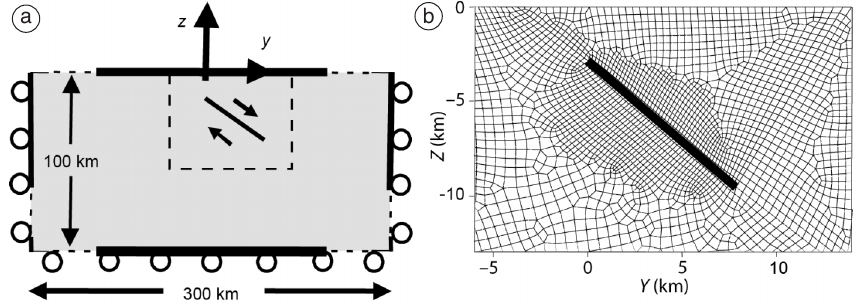
Fig. 1a,b. Two-dimensional finite element model: a) geometry (not on scale) and boundary conditions (circles represent no movement across the edge); b) enlargement of the quadrilateral-element mesh relative to the dashed box shown in